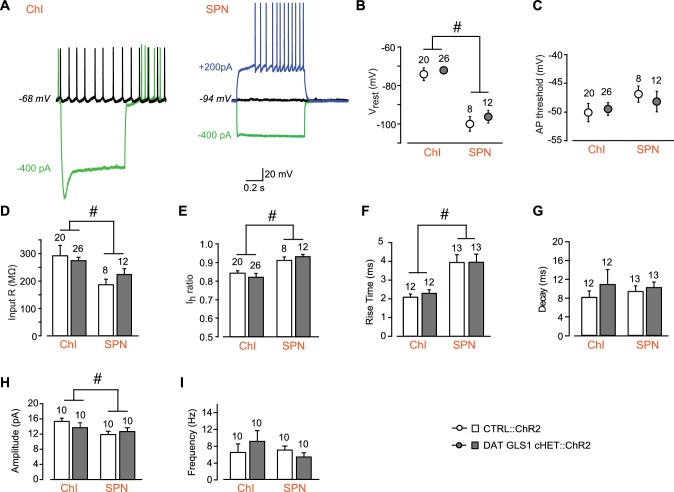
Comparison between CTRL::ChR2 and DAT GLS1 cHET::ChR2 mice showing that intrinsic electrophysiological membrane properties and spontaneous EPSCs measured in NAc shell cells did not differ between genotypes.(A) ChIs and SPNs are identifiable based on their electrophysiological signature under current clamp. The ChI (left) had a resting membrane potential around −70 mV, fired spontaneously (black trace), and showed a voltage sag with hyperpolarizing current injection (green trace). The SPN (right) had a deep resting membrane potential around −100 mV, did not fire spontaneously (black), showed no sag with hyperpolarizing current injection (green trace), and fired rapidly with depolarizing current injection, after a delay (blue trace). (B) The average baseline membrane potential (Vrest) was more negative in SPNs than in ChIs, but not genotypically different. A two-way ANOVA showed a main effect of cell type (F(1,62) = 128.3, p<0.0001, ES partial η2 = 0.67), indicated by the #, but no main effect of genotype (F(1,62) = 1.67, p=0.201) or significant interaction (F(1,62) = 0.138, p=0.711). (C) Action potential (AP) threshold in ChIs and SPNs. A two-way ANOVA showed no main effect of genotype (F(1,62) = 0.53, p=0.819) or cell type (F(1,62) = 2.78, p=0.100), or significant interaction (F(1,62) = 0.480, p=0.491). (D) Input impedance was significantly higher in ChIs compared to SPNs, but not statistically different between genotypes. A two-way ANOVA showed a main effect of cell type (F(1,62) = 15.7, p<0.001, ES partial η2 = 0.20), indicated by the #, but no main effect of genotype (F(1,62) = 0.233, p=0.631) or significant interaction (F(1,62) = 1.96, p=0.167). (E) The hyperpolarization-activated cation current (Ih) ratio was lower in the ChIs than SPNs, revealing the presence of an Ih in ChIs but not SPNs. A two-way ANOVA showed a main effect of cell type (F(1,62) = 15.0, p<0.001, ES partial η2 = 0.20), indicated by the #, but no main effect of genotype (F(1,62) = 0.001, p=0.976) or significant interaction (F(1,62) = 0.856, p=0.358). (F) Characterization of photostimulated DA neuron evoked EPSCs in ChIs and SPNs under voltage clamp revealed that rise time (from 10% to 90% of peak amplitude) was faster in SPNs than ChIs, but not genotypically different. A two-way ANOVA showed a significant cell type effect (F(1,46) = 28.4, p<0.0001, ES partial η2 = 0.08) indicated by the #, but no main effect of genotype (F(1,46) = 1.02, p=0.305) or significant interaction (F(1,46) = 1.02, p=0.305). (G) Decay times of evoked EPSCs under voltage clamp. A two-way ANOVA showed no main effect of genotype (F(1,46) = 2.135; p=0.151) or cell type (F(1,46) = 0.458; p=0.502), or significant interaction (F(1,46) = 1.331; p=0.255). (H) Amplitude of spontaneous EPSCs measured under voltage clamp (holding potential −70 mV) in ChIs and SPNs. A two-way ANOVA showed a main effect of cell type (F(1,36) = 5.85, p<0.021, ES partial η2 = 0.14), indicated by the #, but no main effect of genotype (F(1,36) = 0.257, p=0.615) or significant interaction (F(1,36) = 1.68, p=0.203). (I) Frequency of spontaneous EPSCs measured under voltage clamp (holding potential −70 mV) in ChIs and SPNs. A two-way ANOVA showed no main effect of genotype (F(1,36) = 0.308, p=0.582) or cell type (F(1,36) = 0.764, p=0.388), or significant interaction (F(1,36) = 1.97, p=0.169). Numbers of cells are shown above each bar or circle in the graph. See Figure 3—figure supplement 2—source data 1.xlsx for source data and statistical analysis.DOI:
http://dx.doi.org/10.7554/eLife.27566.012
10.7554/eLife.27566.013Figure 3—figure supplement 2—source data 1.Intrinsic electrophysiological membrane properties and spontaneous EPSCs measured in NAc shell cells of CTRL and DAT GLS1 cHET mice .